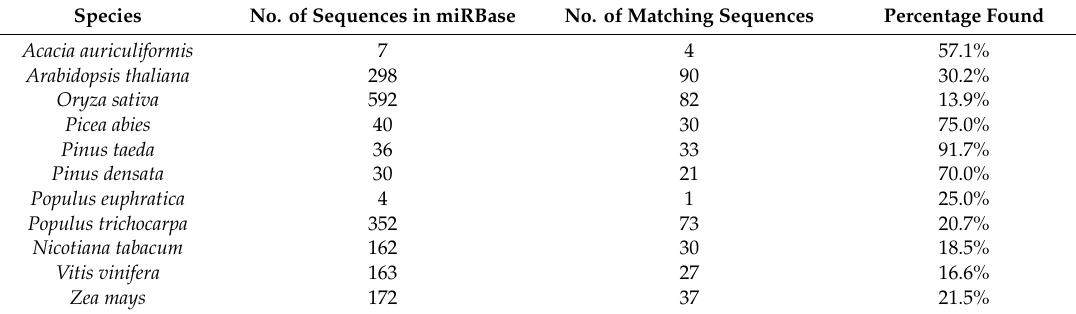
Table 2. Comparison of the number of P. sylvestris small RNAs with matching miRNA sequences in miRBase.